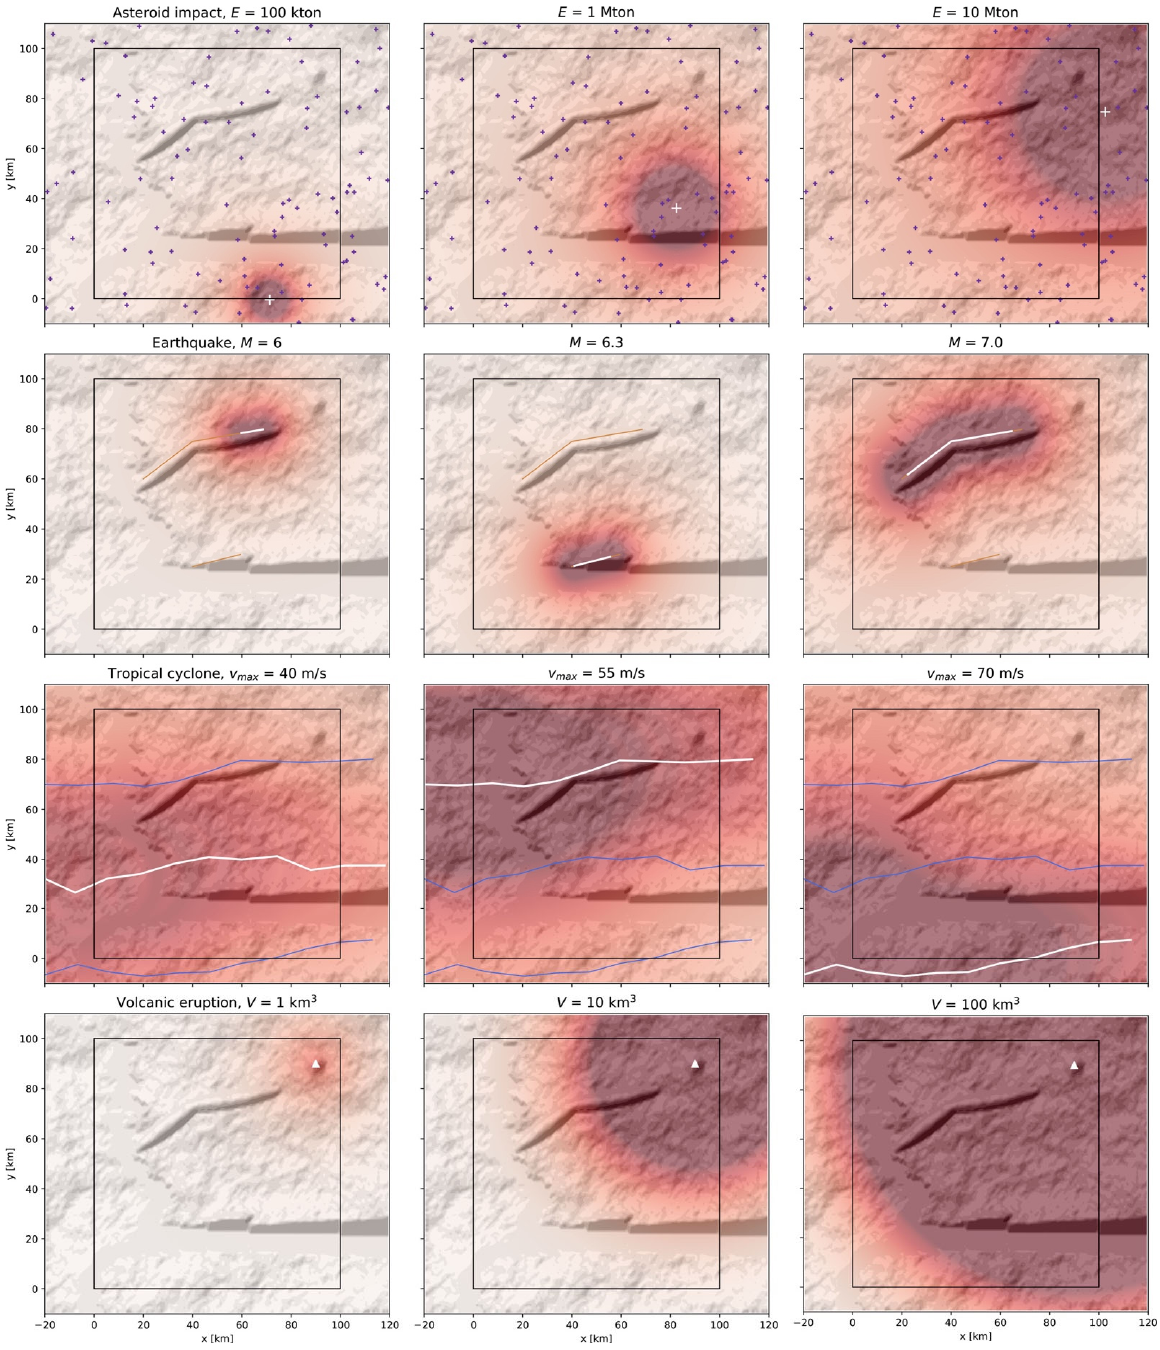
Figure 7. Examples of static intensity footprints for primary perils, based on simple spatial diffusion equations (Section 2.2.1): Asteroid impacts (with kinetic energy E = 100 kton, 1 Mton, or 10 Mton), earthquakes (with magnitude M = 6, 6.3, and 7), tropical cyclones (with maximum windspeed v max = 40, 55, or 70 m/s), and volcanic eruptions (with erupted volume V = 1, 10, or 100 km 3 ). In the simplest configuration in which the hazard intensity is not locally modified by site-specific conditions, the footprints are independent of the underlying topography and soil environmental layers. The color scale saturates at intensities for which heavy damage can be expected: at 1 psi of overpressure for asteroid impacts, 0.4 g of PGA for earthquakes, 45 m/s windspeed for tropical cyclones, and 0.5 m of tephra thickness for volcanic eruptions. White segments and white symbols represent the matching event sources. Other sources are colored by peril category, following Table